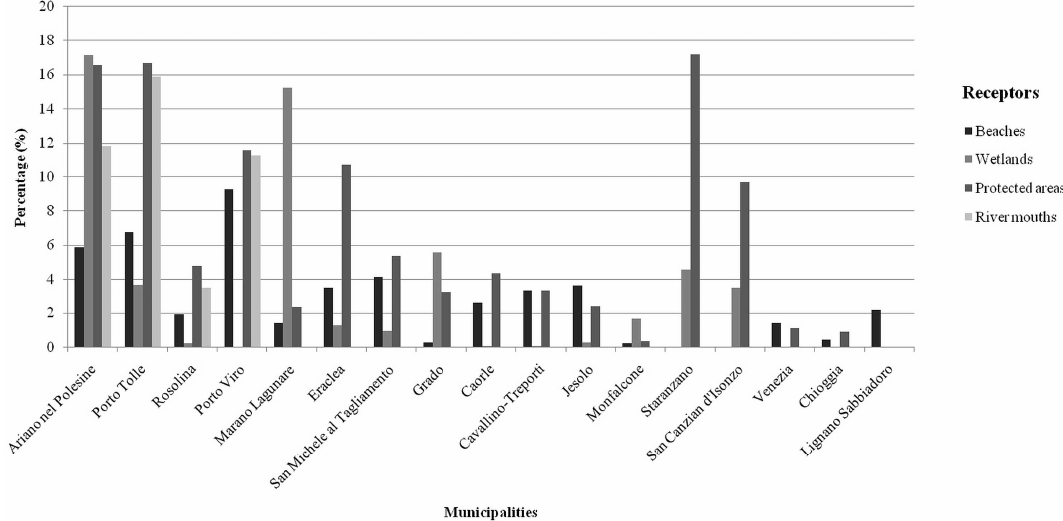
Fig. 11. Percentage of the surface of each receptor (i.e. beaches, wetlands, protected areas and river mouths) affected by higher vulnerability value (i.e. very high and high vulnerability classes) for the coastal erosion impact in each coastal